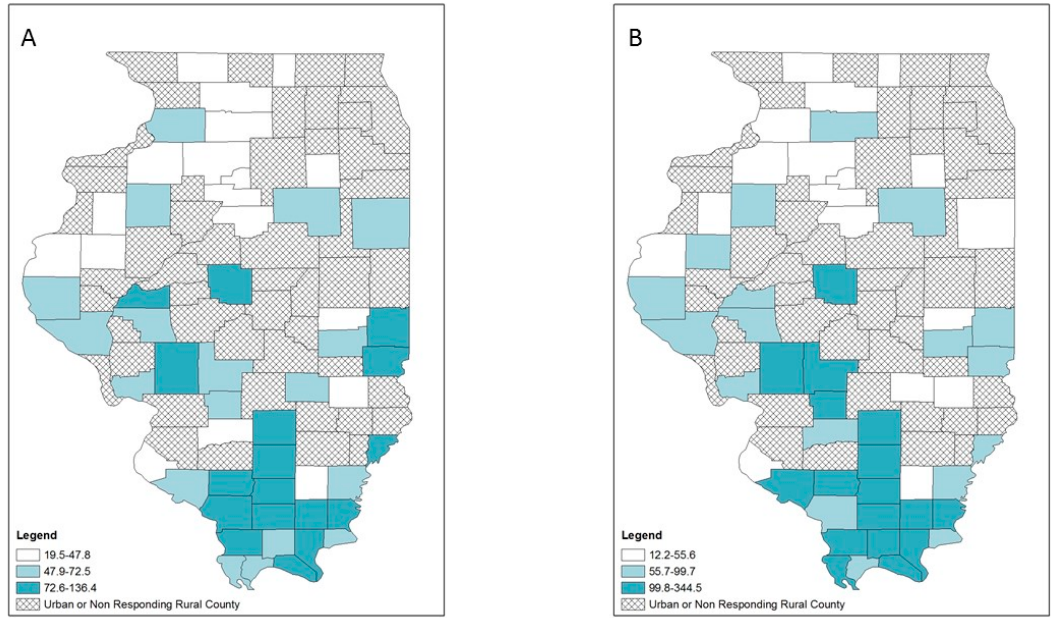
Figure 7. Hepatitis C diagnosis rates per 100,000 population by tertiles, respondent rural counties, Illinois, 2010–2017: ( A ) crude rates; ( B ) empirical Bayes estimated rates. Illinois, 2010 – 2017: ( A ) crude rates; ( B ) empirical Bayes estimated rates.